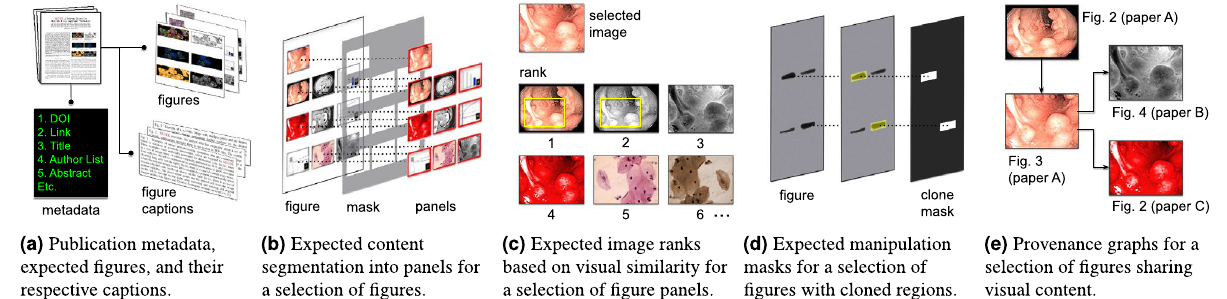
Figure 4. Provided annotations within the SP dataset. In ( a ), the additional data and annotations related to the task of content extraction. Metadata about the publications and links to the original paper figures supplied by the publishers’ websites are provided, along with their respective captions. In ( b ), the annotations related to the task of panel segmentation. For a set of selected paper figures, manually annotated content masks are provided, defining multiple bounding boxes that individually encompass panels of interest for further analyses. In ( c ), the annotations related to the task of image ranking. A set of selected figure panels is provided, with each panel containing its list of visually similar images (i.e., image rank), sorted from the most to the least similar element. In ( d ), annotations related to the task of copy-move detection. For a set of selected paper figures, manually annotated masks are provided, highlighting the cloned regions within each image. In ( e ), annotations related to the task of provenance analysis. Provenance graphs are provided in JSON format, linking a selection of figures that share visual content and are reused across a subset of the dataset papers. Original images within this figure are in the public domain 3–6,24–26